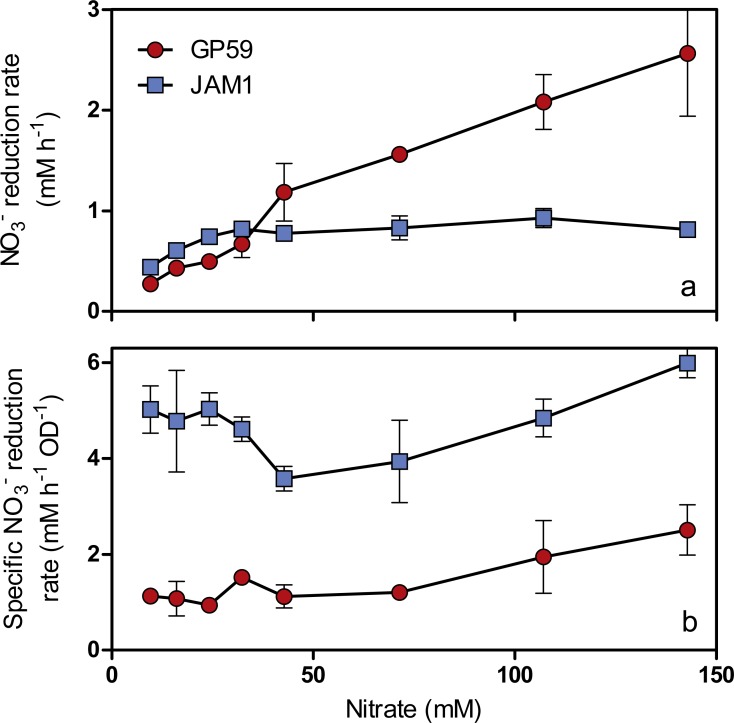
Specific NO\documentclass[12pt]{minimal}
\usepackage{amsmath}
\usepackage{wasysym}
\usepackage{amsfonts}
\usepackage{amssymb}
\usepackage{amsbsy}
\usepackage{upgreek}
\usepackage{mathrsfs}
\setlength{\oddsidemargin}{-69pt}
\begin{document}
}{}${}_{3}^{-}$\end{document}3− reduction rates.(A) NO\documentclass[12pt]{minimal}
\usepackage{amsmath}
\usepackage{wasysym}
\usepackage{amsfonts}
\usepackage{amssymb}
\usepackage{amsbsy}
\usepackage{upgreek}
\usepackage{mathrsfs}
\setlength{\oddsidemargin}{-69pt}
\begin{document}
}{}${}_{3}^{-}$\end{document}3− reduction rates of strains GP59 and JAM1. Each point is the average with standard deviation of triplicate anoxic cultures. (B) Specific NO\documentclass[12pt]{minimal}
\usepackage{amsmath}
\usepackage{wasysym}
\usepackage{amsfonts}
\usepackage{amssymb}
\usepackage{amsbsy}
\usepackage{upgreek}
\usepackage{mathrsfs}
\setlength{\oddsidemargin}{-69pt}
\begin{document}
}{}${}_{3}^{-}$\end{document}3− reduction rates. These rates were calculated with the NO\documentclass[12pt]{minimal}
\usepackage{amsmath}
\usepackage{wasysym}
\usepackage{amsfonts}
\usepackage{amssymb}
\usepackage{amsbsy}
\usepackage{upgreek}
\usepackage{mathrsfs}
\setlength{\oddsidemargin}{-69pt}
\begin{document}
}{}${}_{3}^{-}$\end{document}3− reduction rates by the generated culture biomass (OD600nm) at the end of the exponential phase.